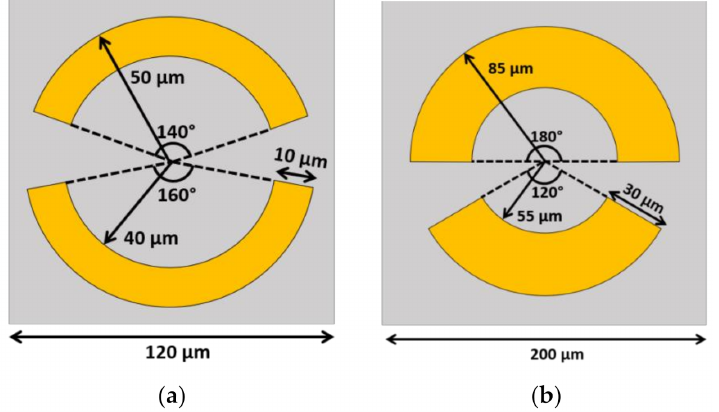
Figure 8. The schematic of the asymmetric split-ring resonators. ( a ) The unit cell that proposed in [197] to detect the protein. The central angles are 140 and 160 degrees with the inner and outer radii as 40 and 50 µ m, respectively. ( b ) The unit cell proposed in [198] to detect DNA. Ruiyun Zhou et al. [202] proposed DNA detection by using another complementary asymmetry split-ring (CASR). The unit cell length is 200 µ m with a split-ring that has an outer radius of 85 µ m and a 55 µ m inner radius, as shown in Figure 8b. Two gaps are introduced at the central angle of 120 ◦ and 180 ◦ . A 100 nm thick gold (Au)